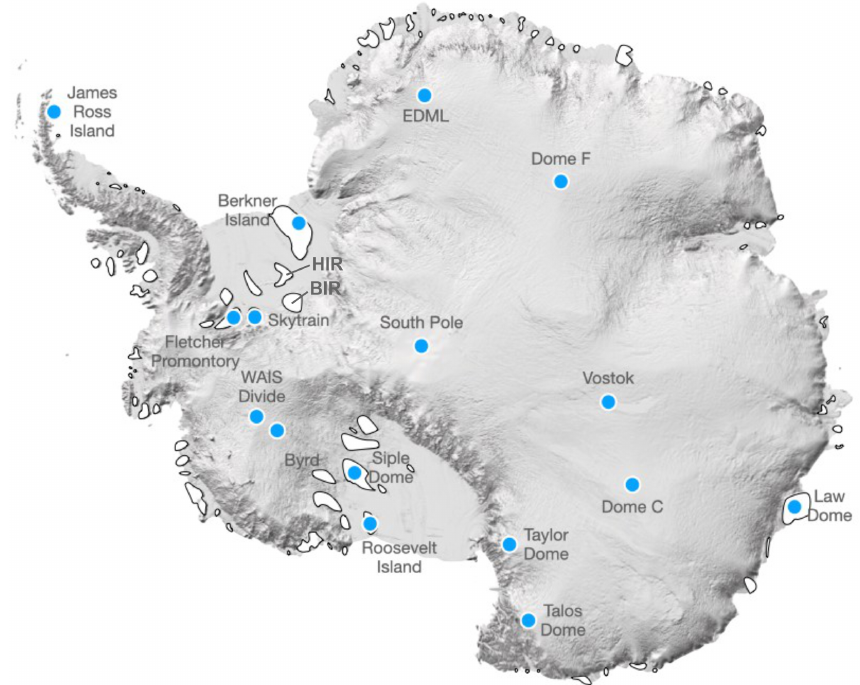
Figure 7. Map of Antarctica showing the location of existing and potential ice core sites from which Holocene ice has been, or could be, obtained. Deep ice core sites from where Holocene ice has already been collected are represented by blue dots, and suitable locations for future sampling of Holocene ice near grounding zones – ice rises and ridges – are highlighted as white areas (locations from Matsuoka et al., 2015); “HIR” and “BIR” show the location of Henry and Bungenstock ice rises, respectively. The Reference Elevation Model of Antarctica hillshade base is from Howat et al.